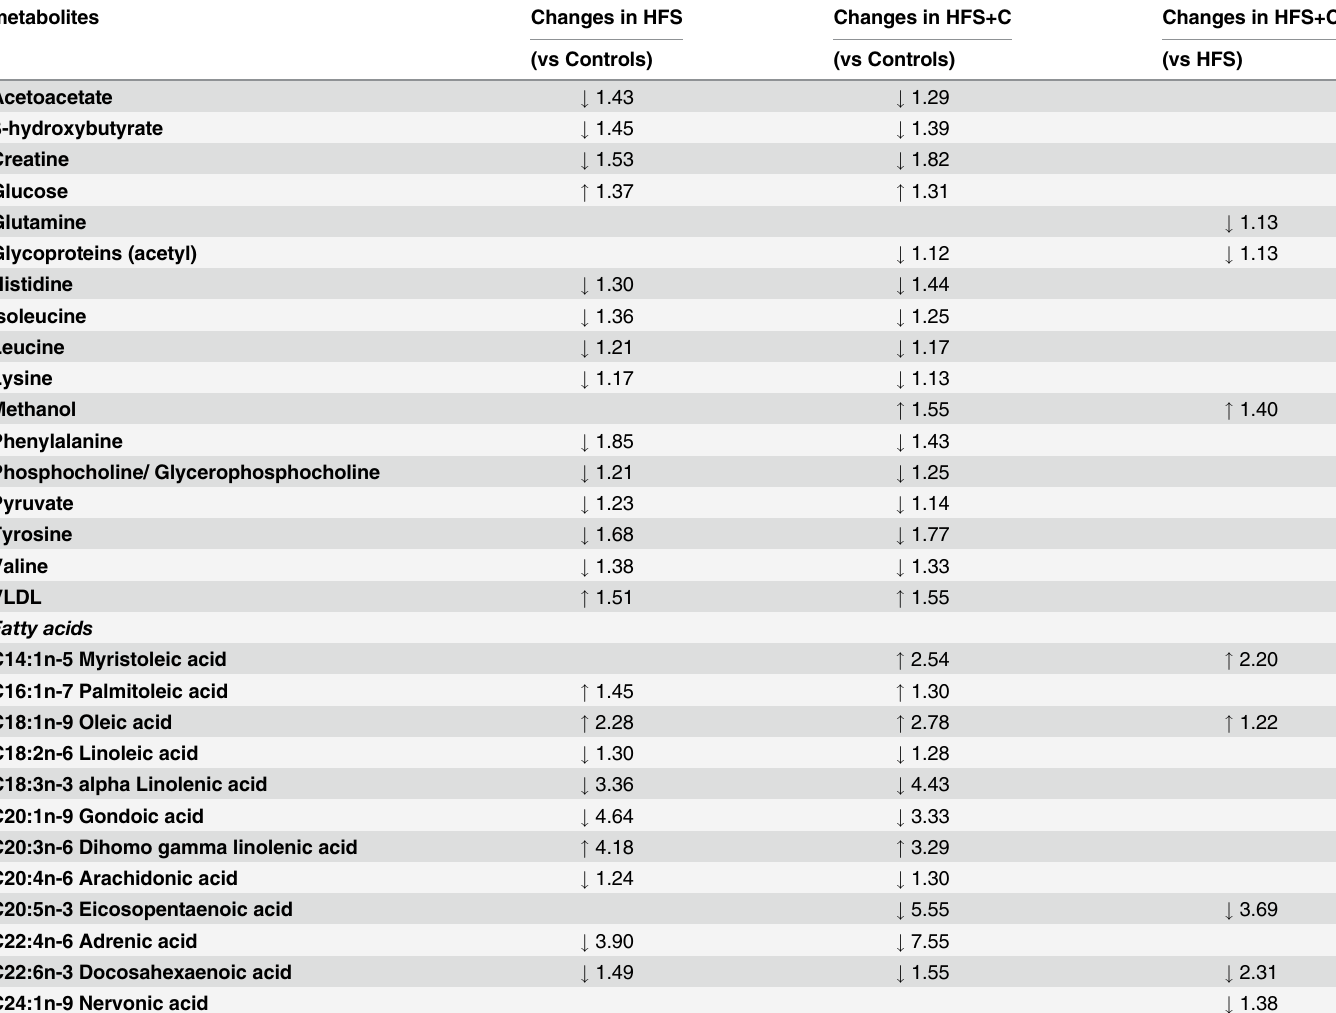
Table 5. Significantly differential metabolites in the rat serum of control, HFS and HFS+C